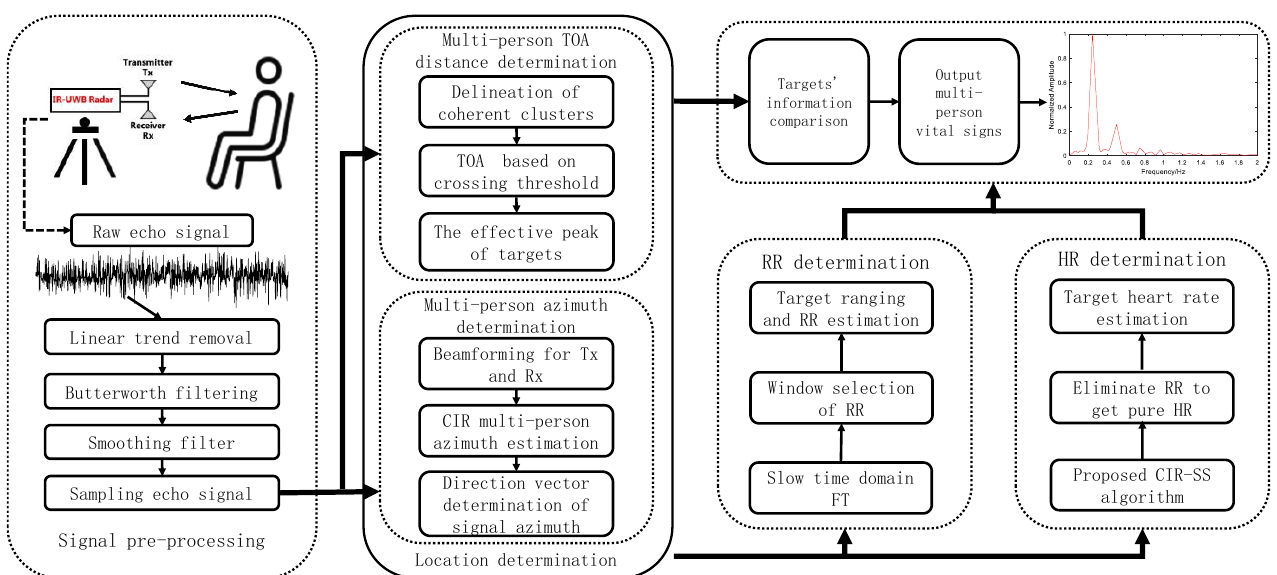
Figure 1. The system flow chart of this study.